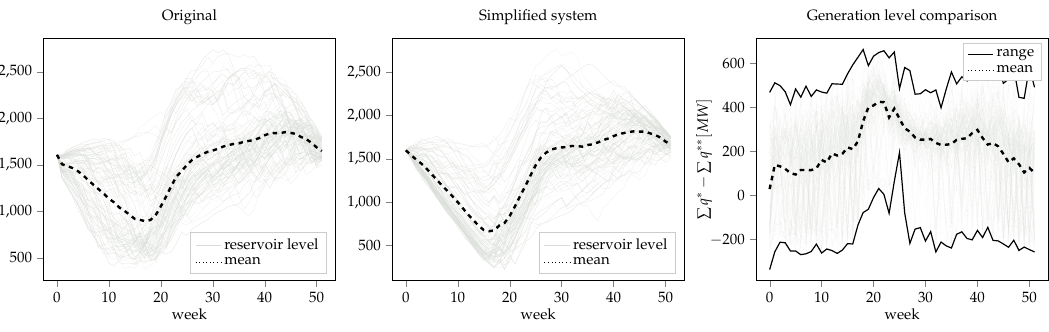
Figure 5. Result comparison of the original and simplified